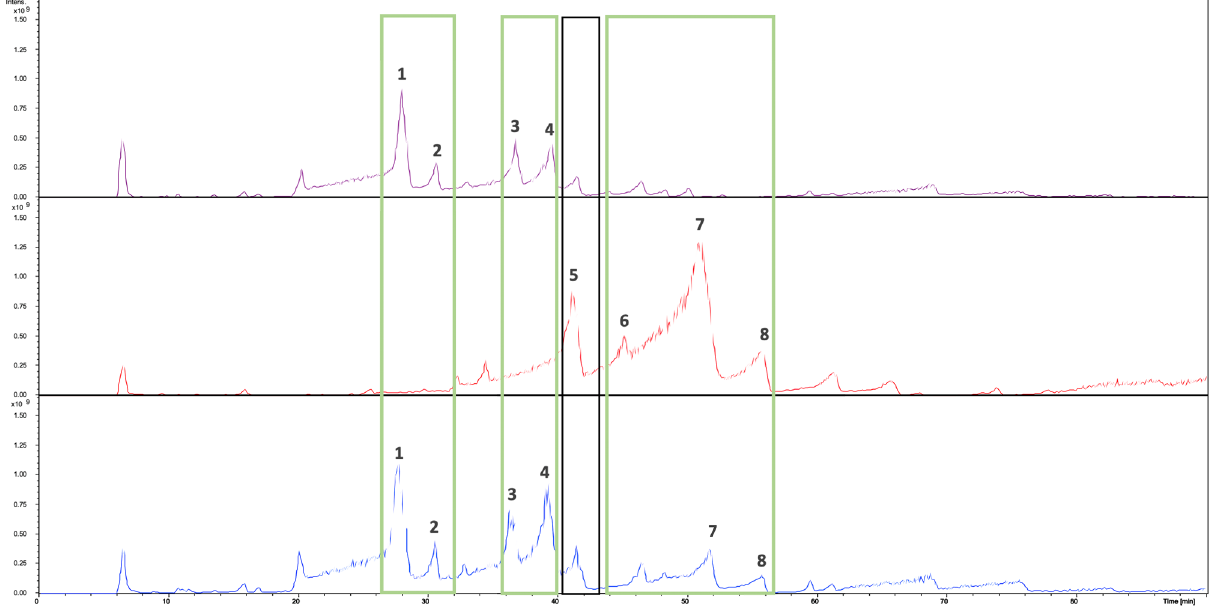
Figure 7. LC–MS chromatogram of isolated muropeptides from L. lactis NZ9000Cm (purple), L. lactis NZ9000NsrFP (red) and L. lactis NZ9000NsrF H202A P (blue). The peaks that only occur in L. lactis NZ9000Cm and L. lactis NZ9000NsrF H202A P are framed in green. Black framed is the peak, which can especially be observed in L. lactis NZ9000NsrFP. Peak 1: GlcNAc-MurNAc-l-Ala-d-iGln-l-Lys-(d-Asn); peak 2: GlcNAc- MurNAc-l-Ala-d-iGln-l-Lys-(d-Asp); peak 3: GlcNAc-MurNAc-l-Ala-d-iGln-l-Lys-(d-Asn)-d-Ala; peak 4: GlcNAc-MurNAc-l-Ala-d-iGln-l-Lys-(d-Asn)-d-Ala-d-Ala; peak 5: